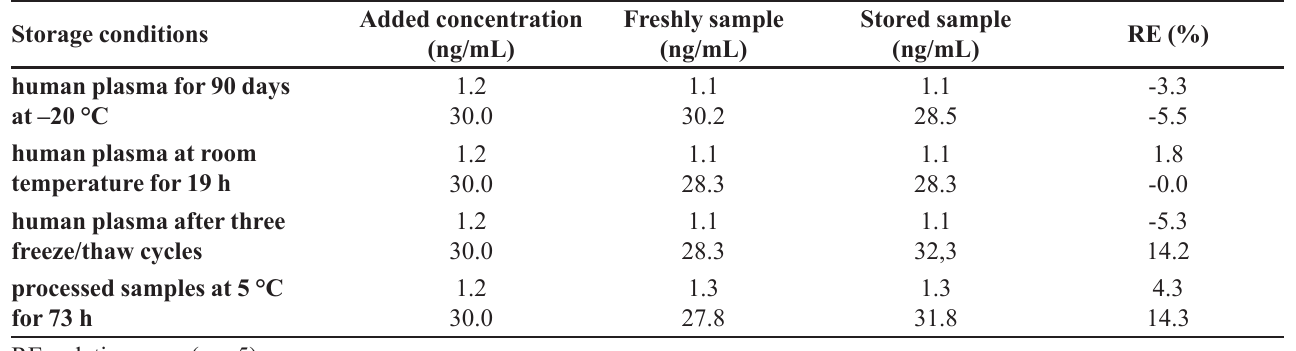
TABLE III - Stability of simvastatin in human plasma under various conditions (n = 5) Storage conditions